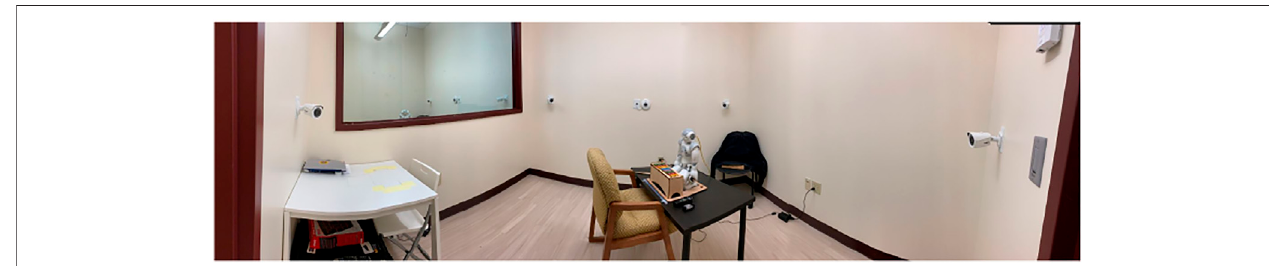
FIGURE 3 | Experiment room.